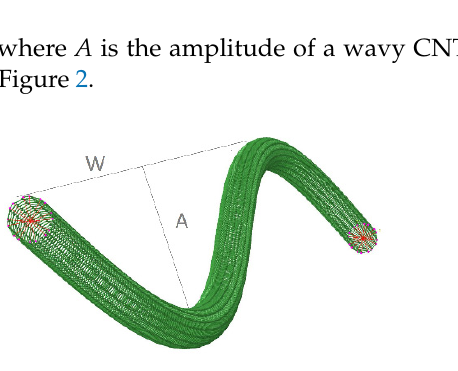
Figure 2. Schematic illustration of a curved CNT.